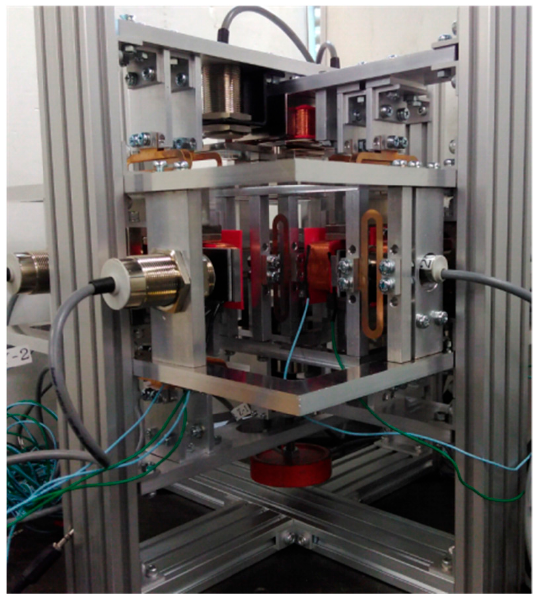
Figure 8. Photograph of the instrument [23].